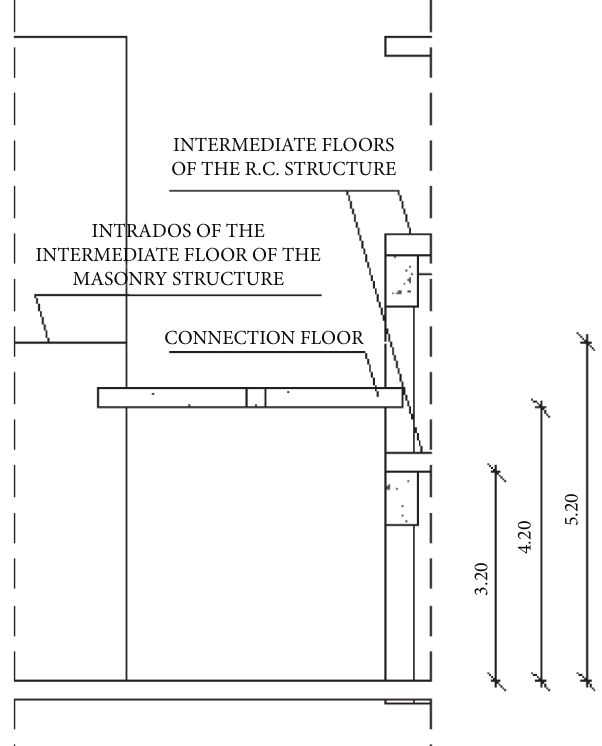
Figure 8: Transversal view of the connecting floor.